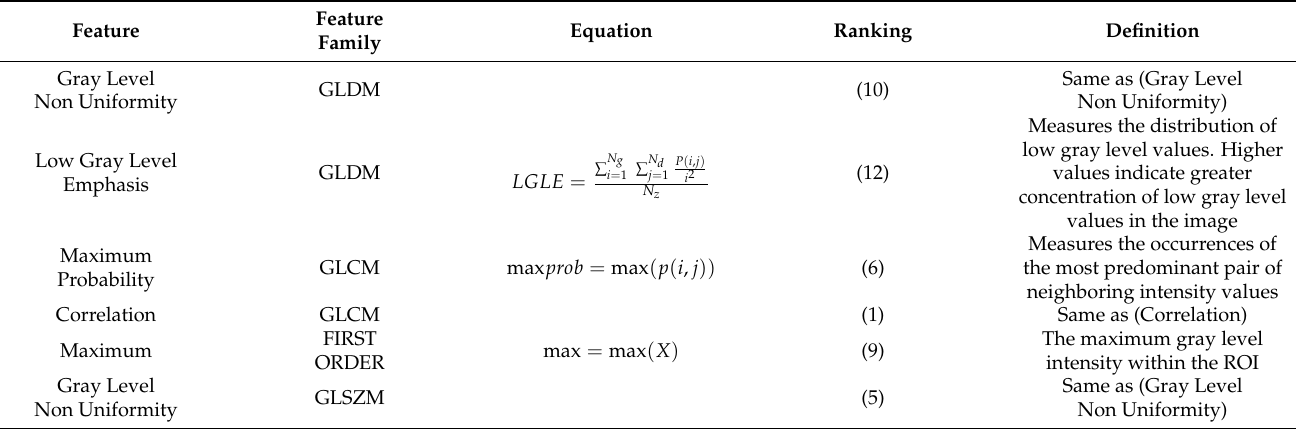
Table 4. The PG ROI Features Incorporated in the Optimal Classification